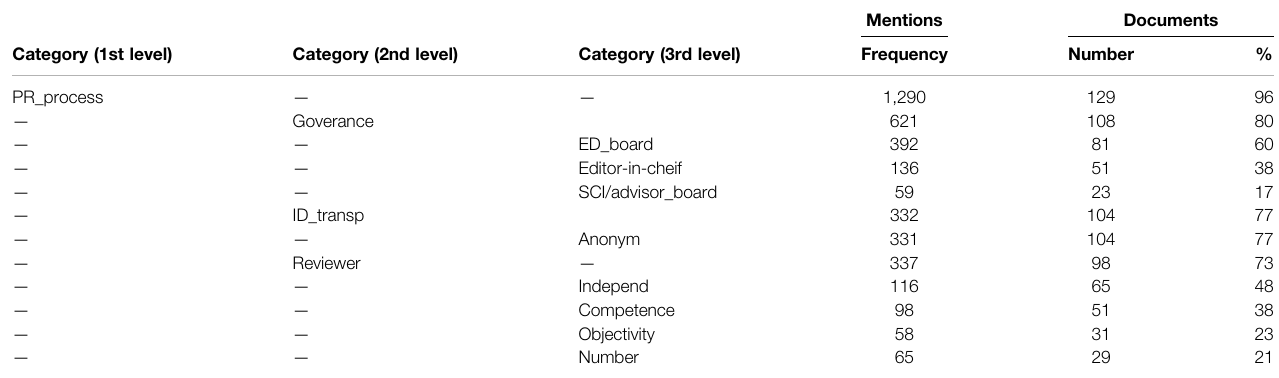
TABLE 3 | Peer review process categories (found in more than 10% of the